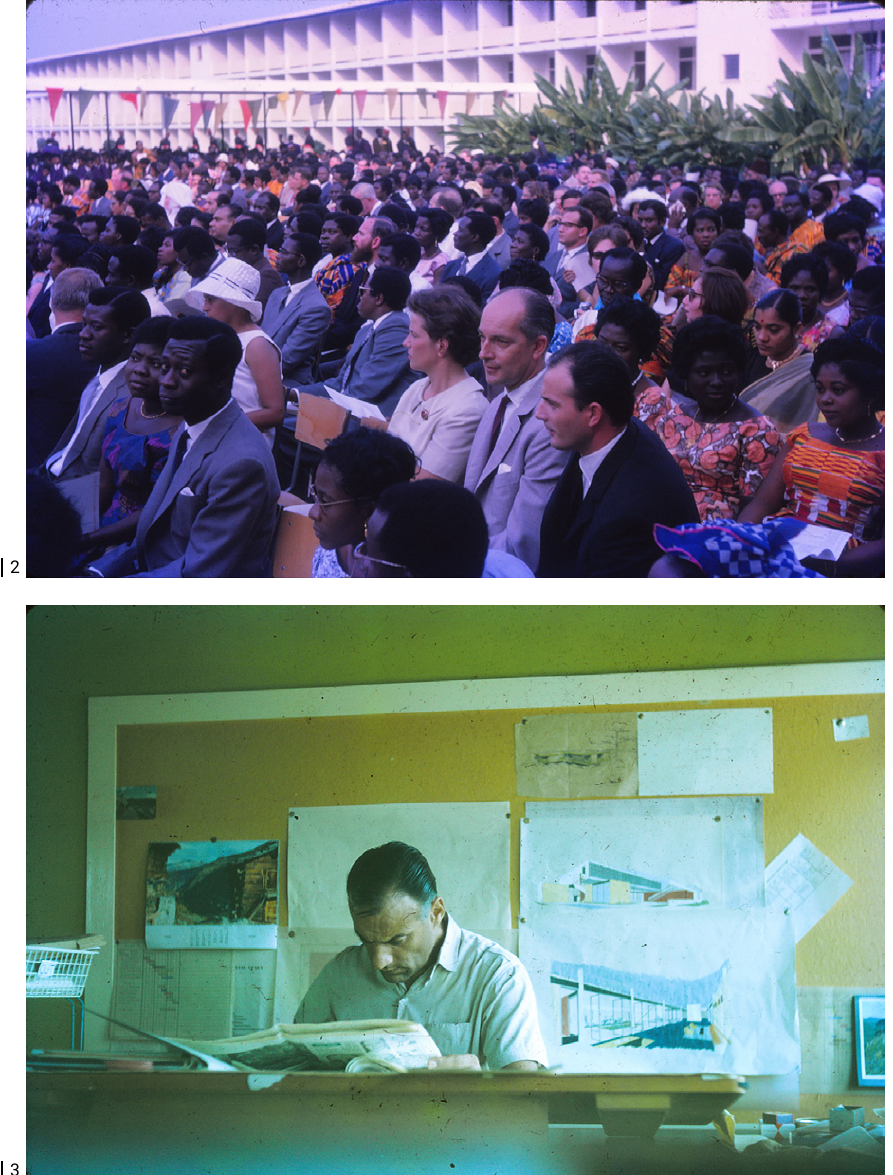
sectional perspective drawings for Chancellor’s Residence